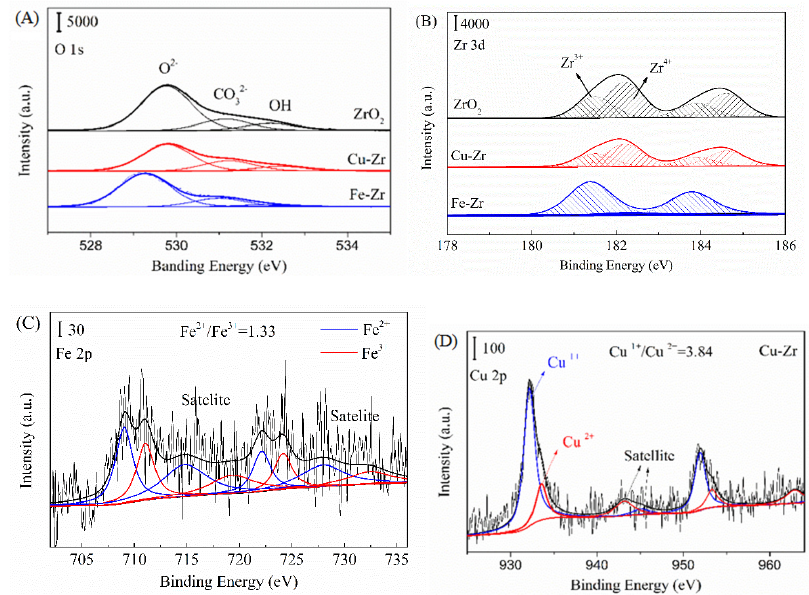
Figure 3. X-ray photoelectron spectroscopy (XPS) profiles of ZrO 2 support, and Cu-Zr and Fe-Zr calcined catalysts. (A) The O 1s, (B) Zr 3d, (C) Fe 2p, and (D) Cu 2p. All the data are referenced using the C 1s peak at 284.6 eV. Table 2. Elemental composition of ZrO 2 , Cu-Zr calcined catalyst and Fe-Zr calcined catalyst from XPS analysis.